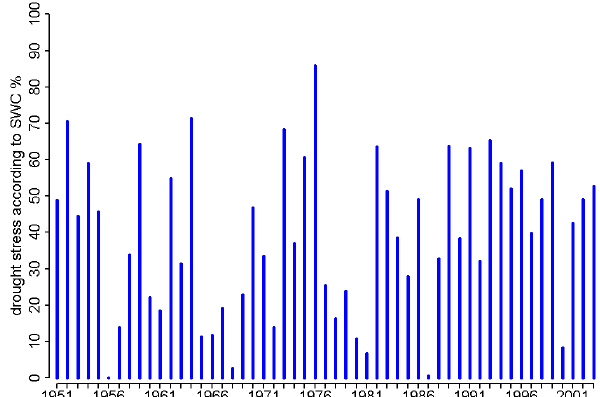
Fig. 4. Drought stress index SWC for an even site and an avail- able water capacity of 150mm; period 1951–2003; climate station “Deuselbach”, Germany.